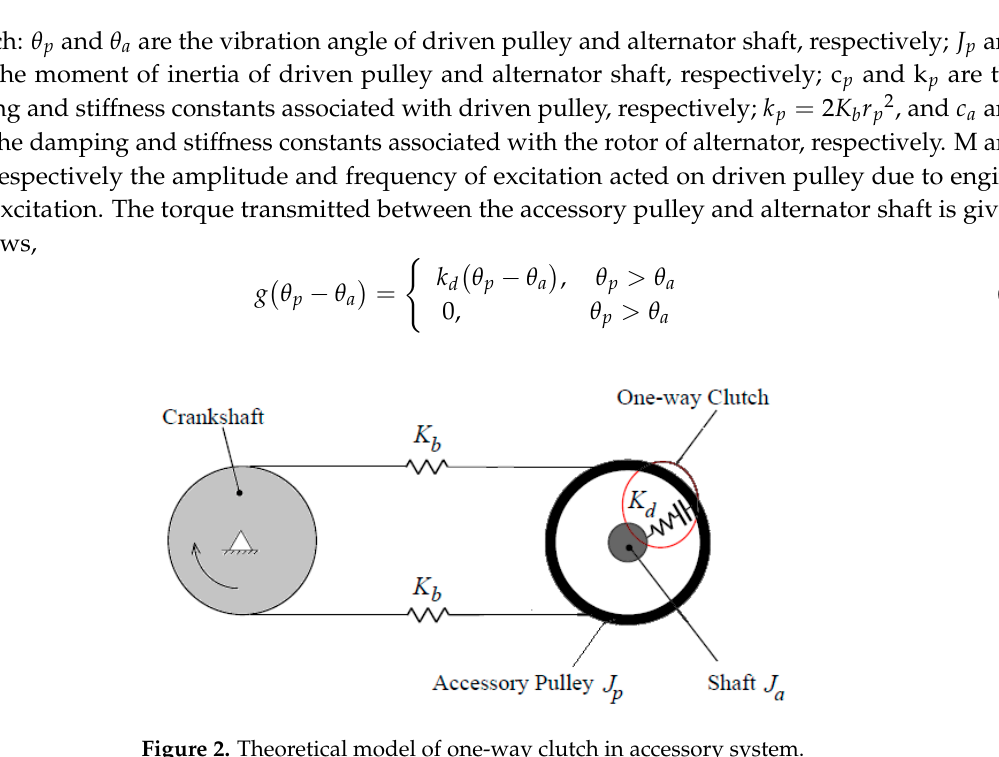
Figure 2. Theoretical model of one-way clutch in accessory system.